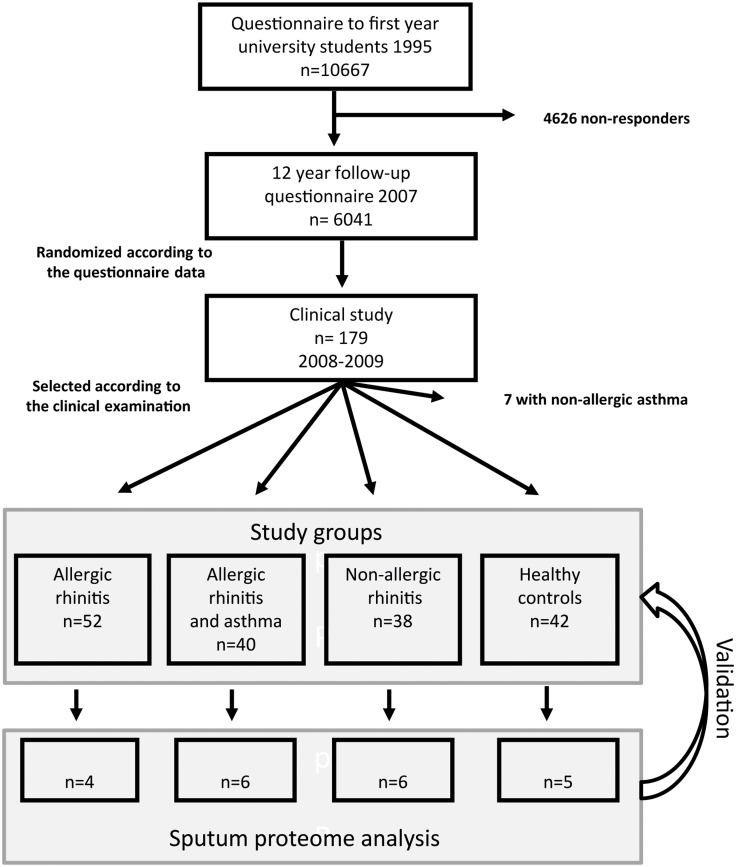
Study flow chart.